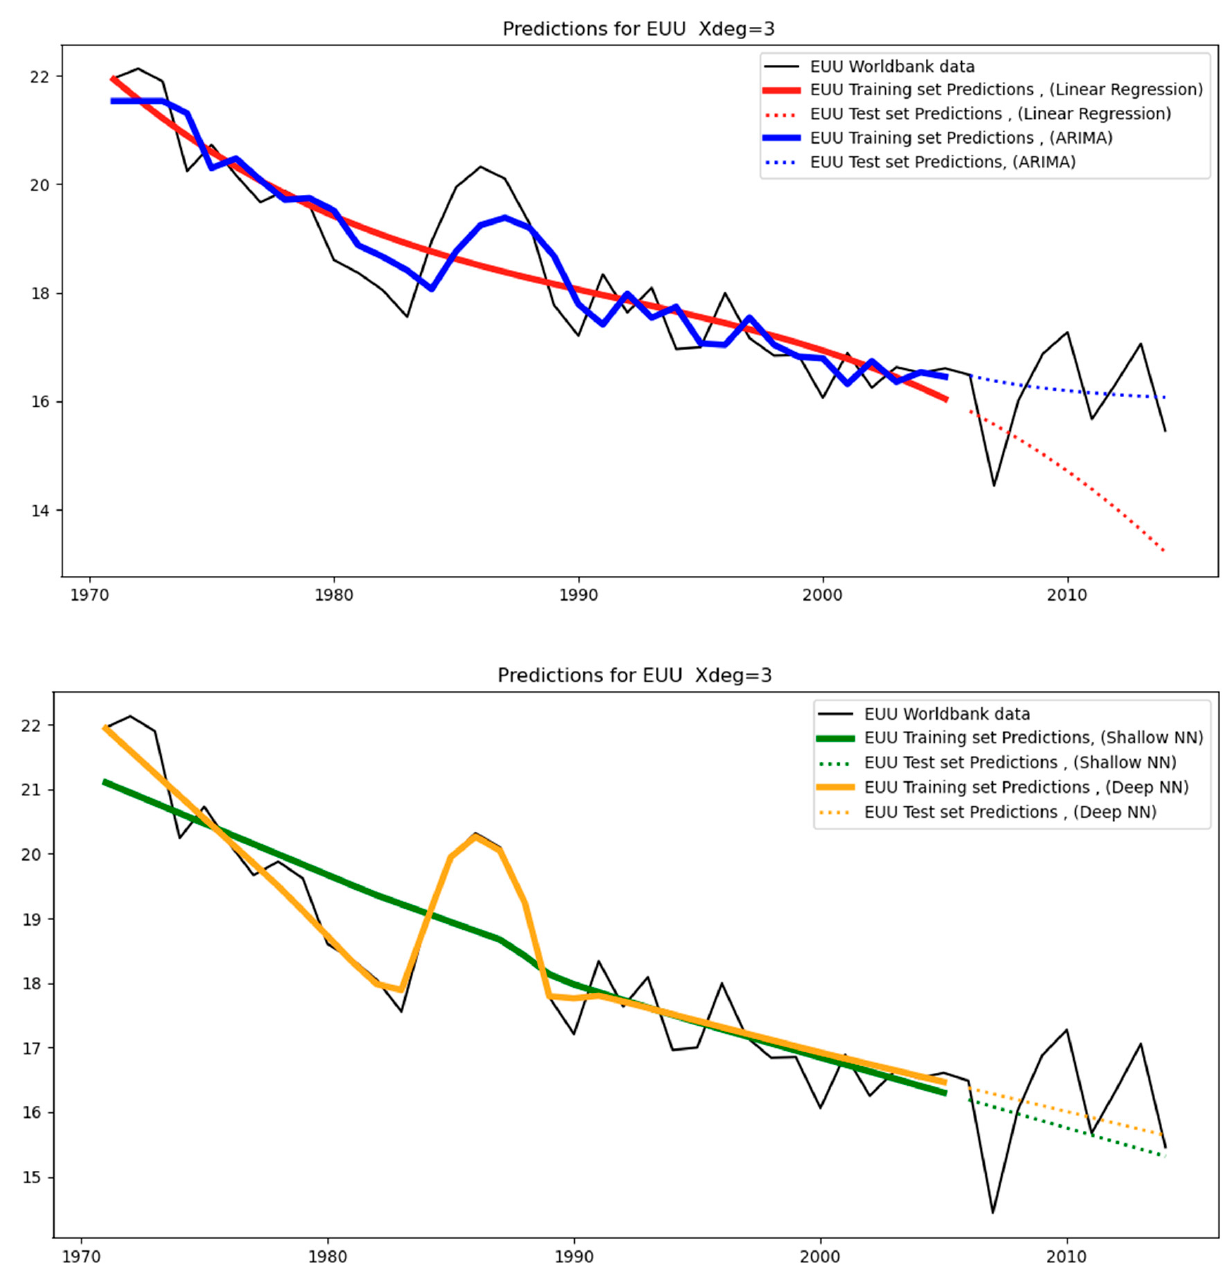
Figure 9. Predictions for the European Union (EUU), with a third-degree polynomial (Xdeg = 3), are shown for both the training set (periods 1971–2005) and the test set (periods 2006–2014), using linear regression (LR), ARIMA, shallow neural networks, and deep neural network models.